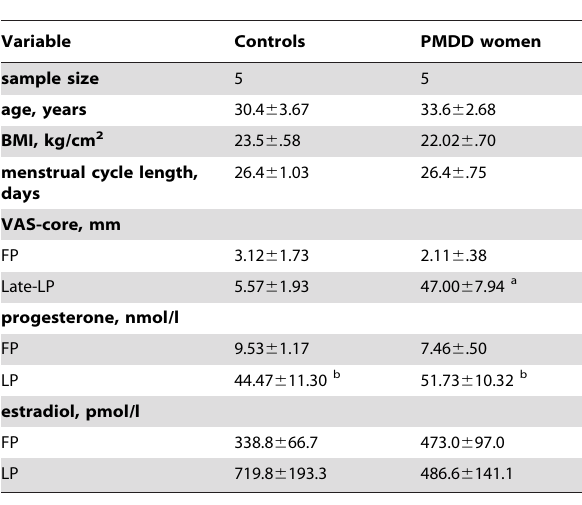
Table 1. Characteristics of controls and PMDD participants { . Table 2. Characteristics of the expanded group of controls and PMDD participants {